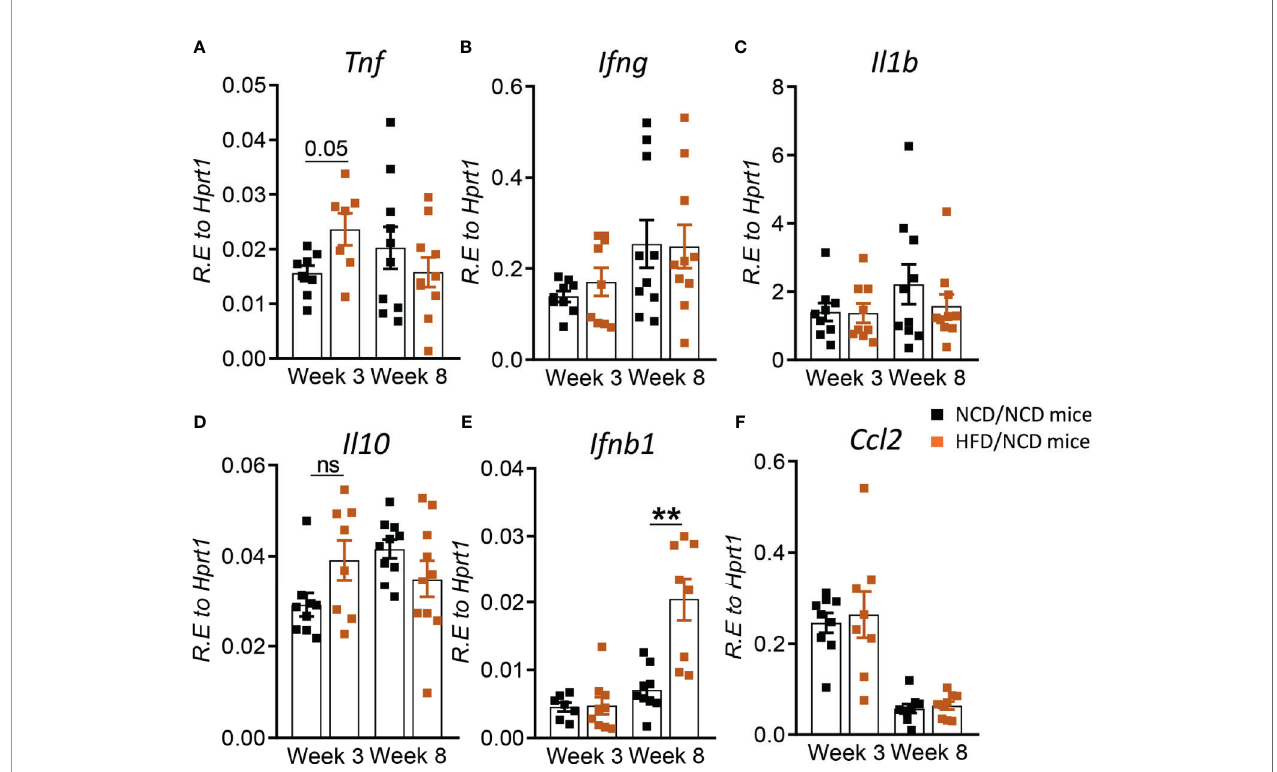
FIGURE 9 | Restoration of glucose tolerance improves blood cytokine pro fi les. Cytokine mRNA expression was determined by qRT-PCR in blood from NCD- and HFD-fed mice at 3- and 8-weeks p.i. (A) Tnf , (B) Ifng , (C) Il1b , (D) Il10 , (E) Ifnb1 , and (F) Ccl2 . Data are means ± SEM (n=8-10 mice/group analyzed in one independent experiment). Data analysis was performed by Mann-Whitney U test. ns = not signi fi cant **p <